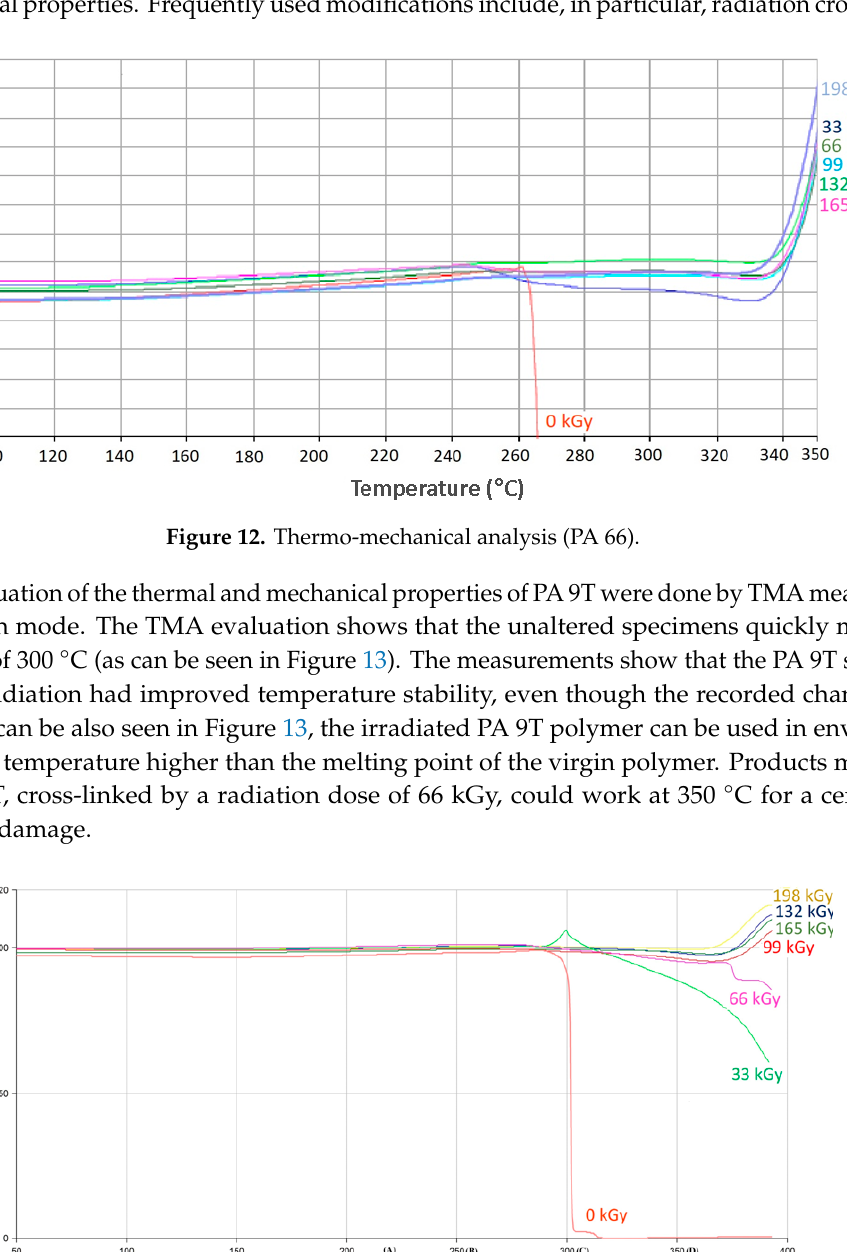
Figure 11. Thermo-mechanical analysis (TMA) (PA 6).